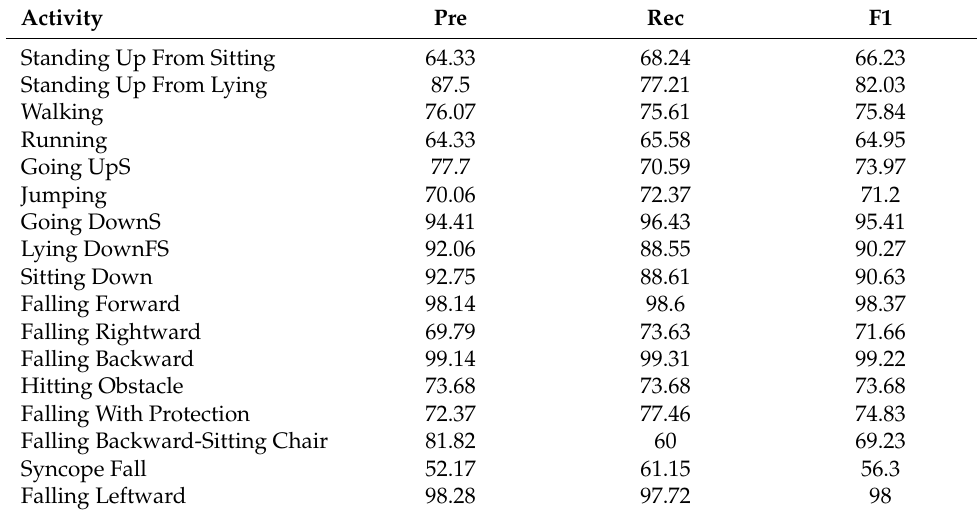
Table 11. Classification rates (%) of the best model of the UniMiB-SHAR dataset using RF.